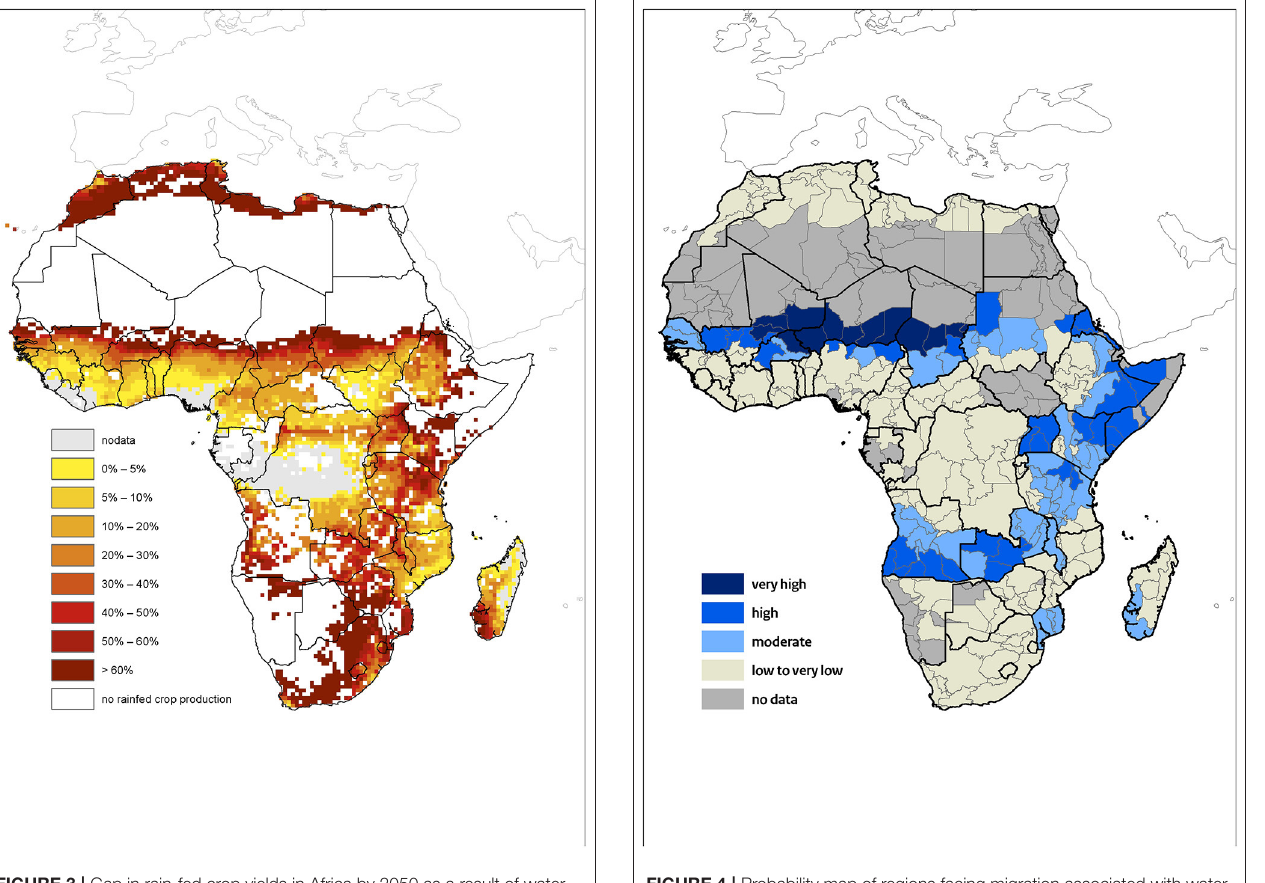
FIGURE 3 | Gap in rain-fed crop yields in Africa by 2050 as a result of water stress.